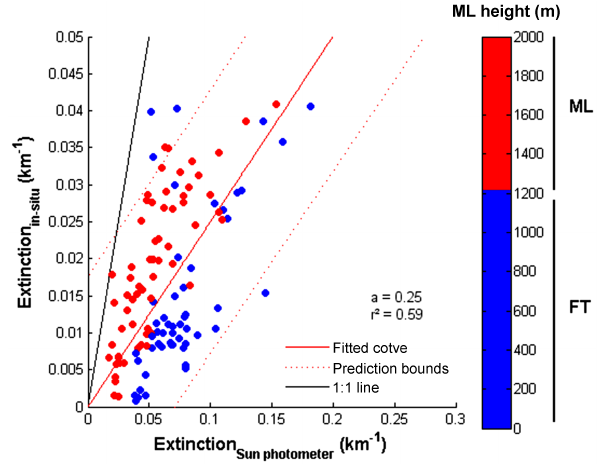
Figure 5. Scatter plot of in situ and sun photometer extinction coef- ficients at 675nm after filtering the multilayer cases of high-altitude transport using STRAT algorithm coloured by the ML height (from WCT